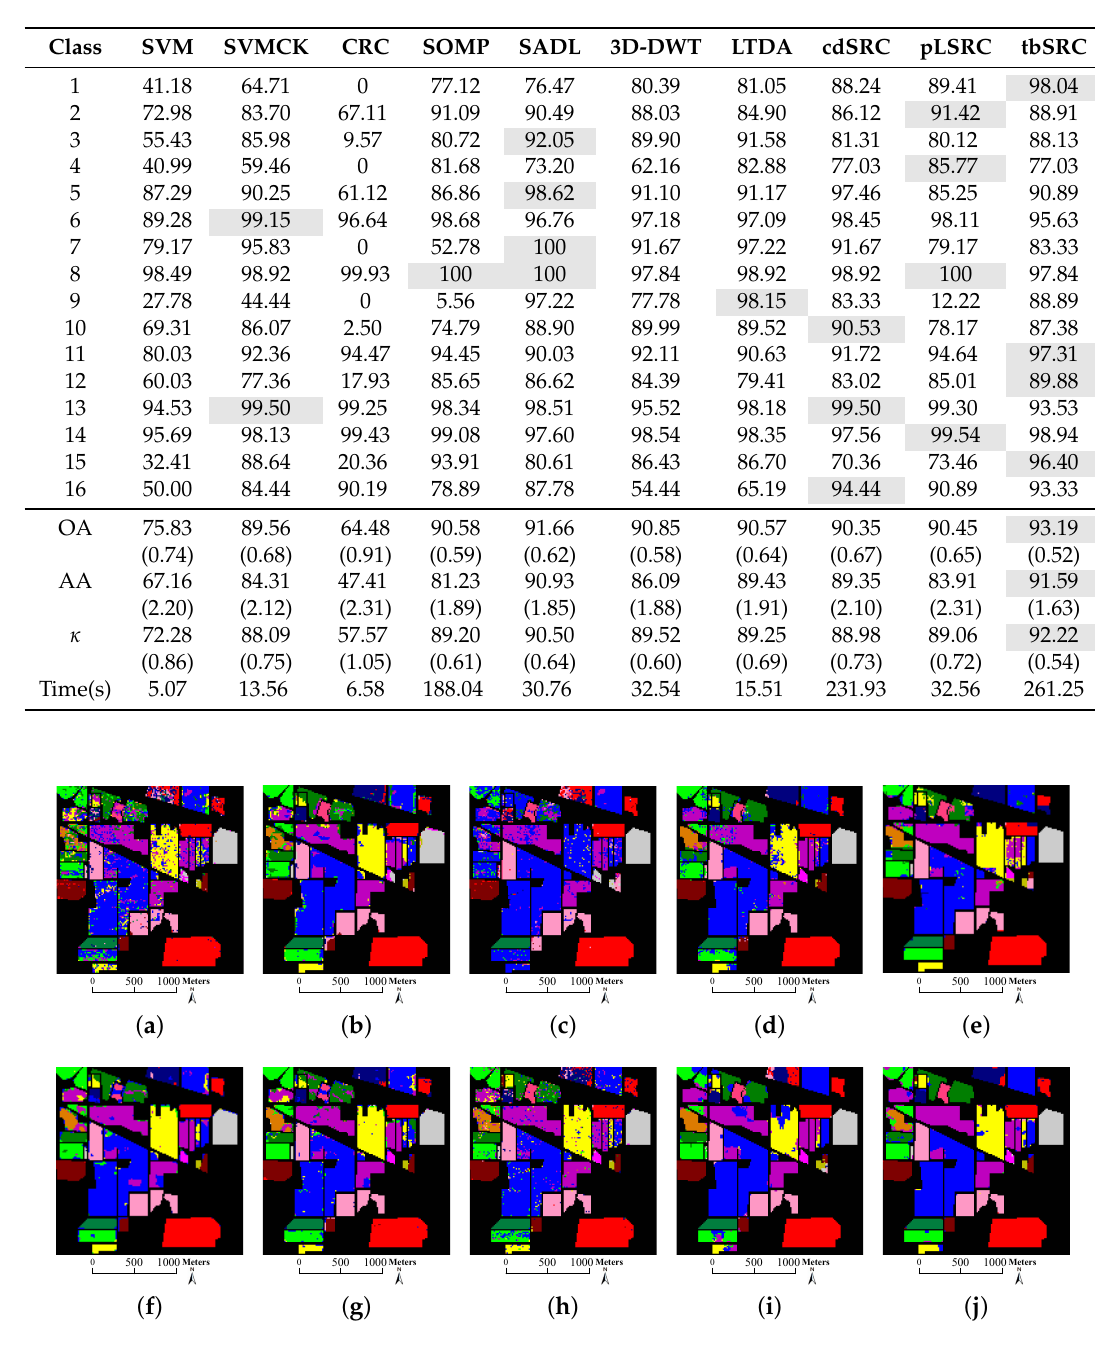
Table 2. Classification accuracy (%) and standard deviation (in bracket) of different methods for the Indian Pines data.